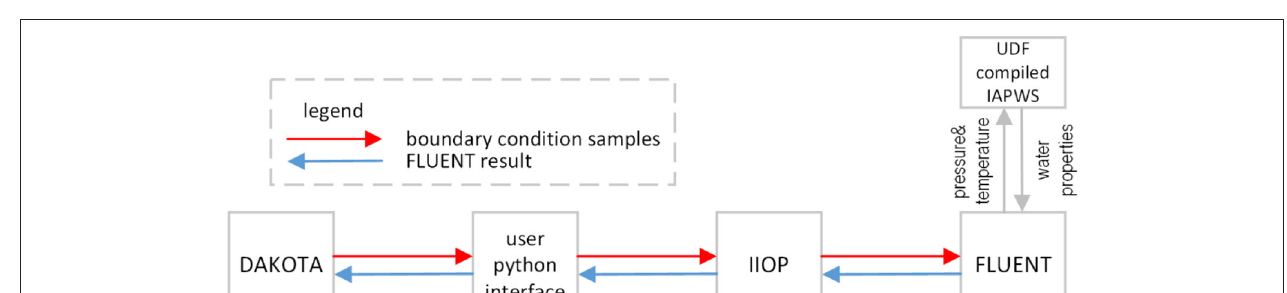
FIGURE 1 | Geometry and boundary conditions.